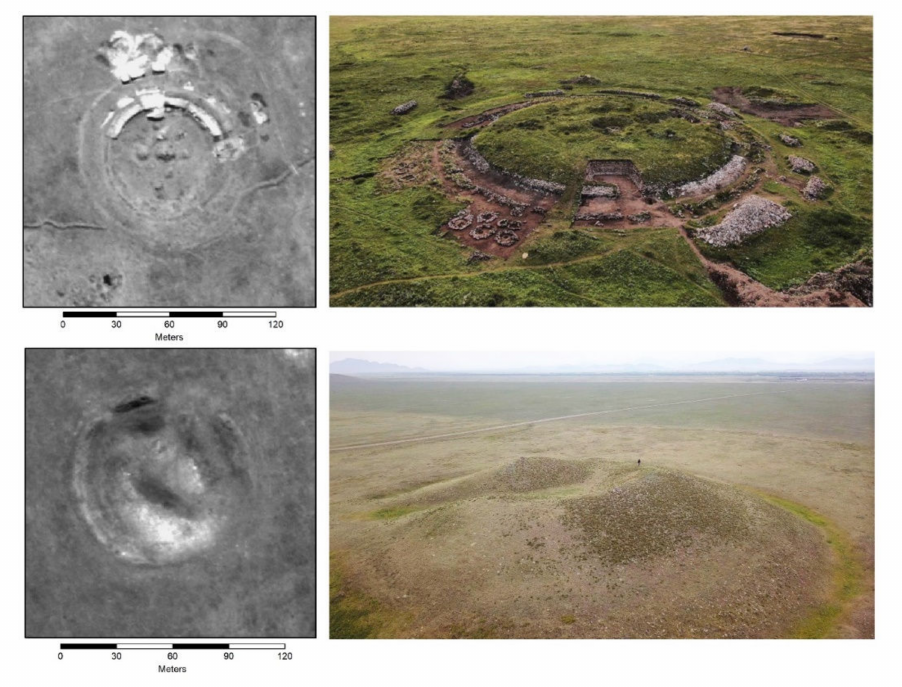
Figure 7. The two large “royal” burial mounds marked in Figure 6 are both heavily impacted by looting. Top (1): despite large looting pits in the center of the stone mound, the archaeological investigation is yielding results, undisturbed peripheral burials have been found at Chinge-tei 1. Bottom (2): The center of this “royal” tomb has been completely destroyed by looters. The small person in black gives a sense of the size of these monuments (Photographs by T.